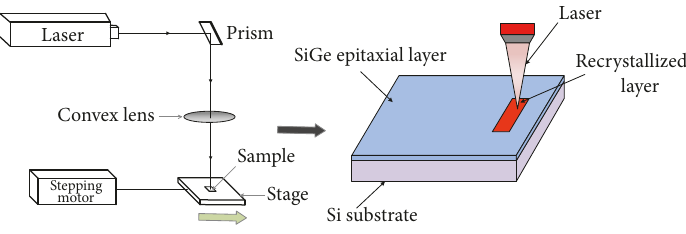
Figure 1: Schematic diagram of the laser recrystallization process.